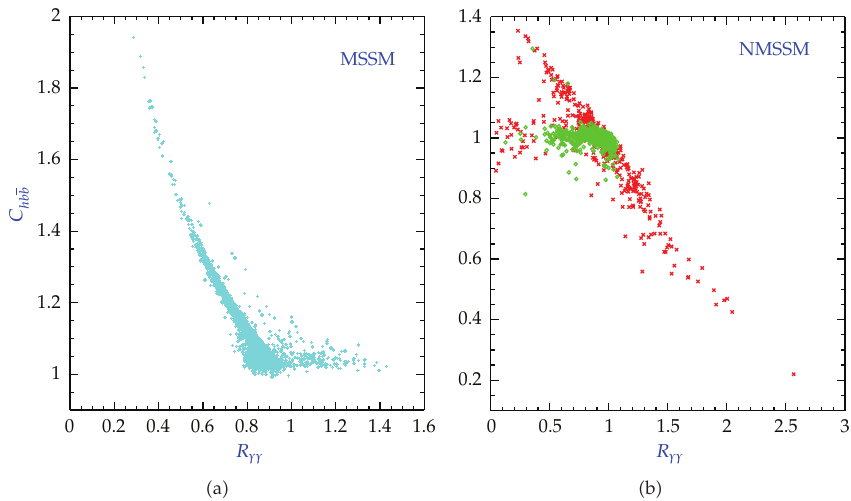
Figure 4: Same as Figure 1, but only for the MSSM, showing the correlation between m (cid:4) τ coupling C hγγ , μ , and tan β , respectively. The purple points correspond to R γγ > 1.